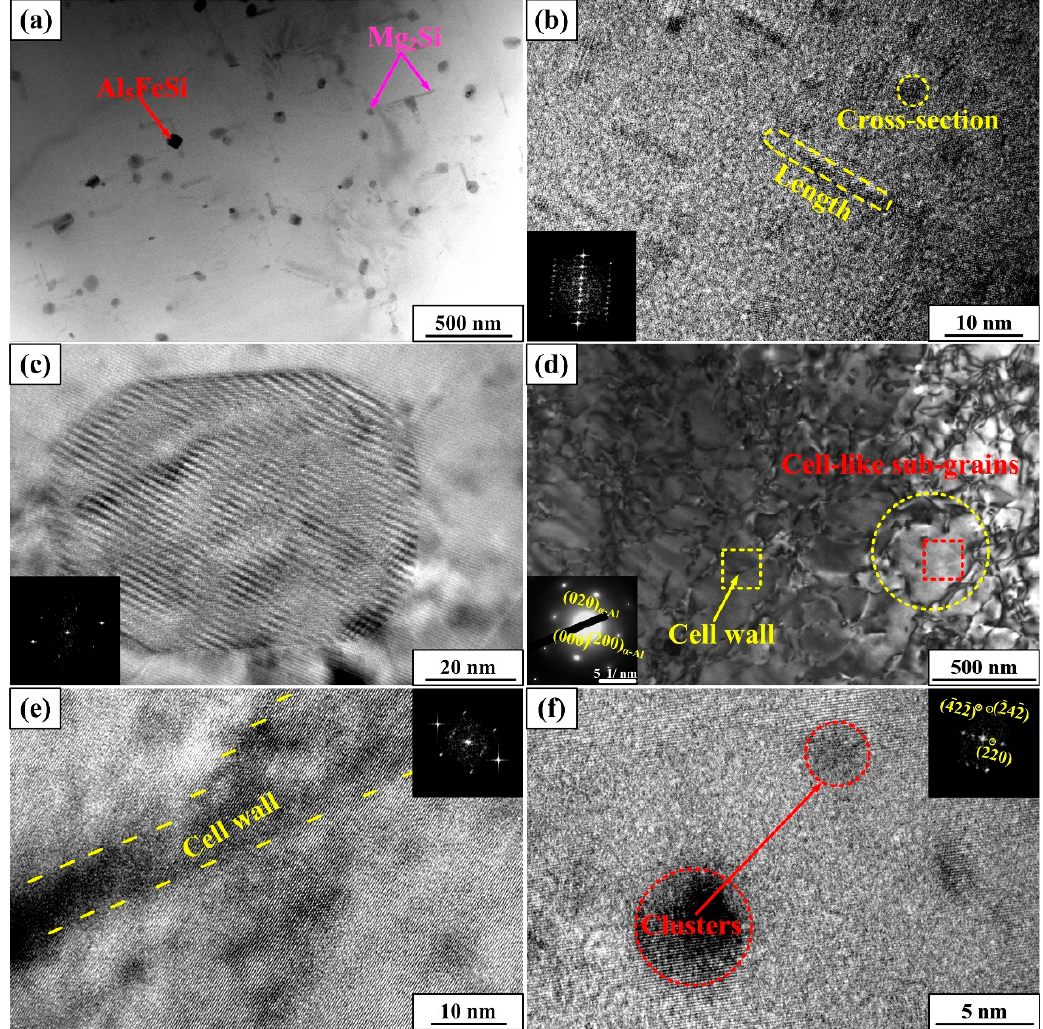
Figure 5. TEM images showing ( a ) precipitates in T6 sample; ( b ) high-resolution transmission electron microscopy (HRTEM) figure and fast Fourier-transform (FFT) of Mg 2 Si in ( a ); ( c ) HRTEM figure and FFT of Al 5 FeSi in ( a ); ( d ) Sub-grains in S + EA sample; ( e ) HRTEM and FFT of cell wall in ( d ); ( f ) HRTEM and FFT of clusters. Materials 2019 , 12 , x FOR PEER REVIEW